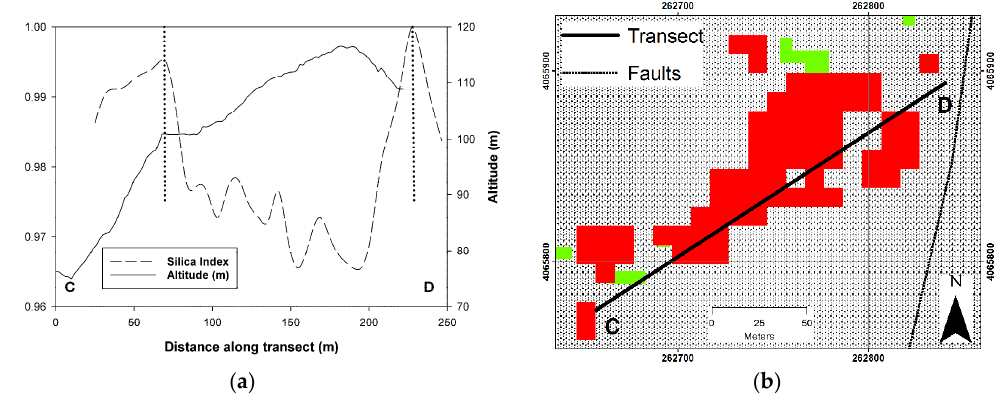
Figure 6. ( a ) Transect (C-D) showing topography and silica index. ( b ) Transect (C-D) from southwest-to-northeast across Silicified Breccia bodies at Triades (B). Dotted lines show limits of mineralized zone.